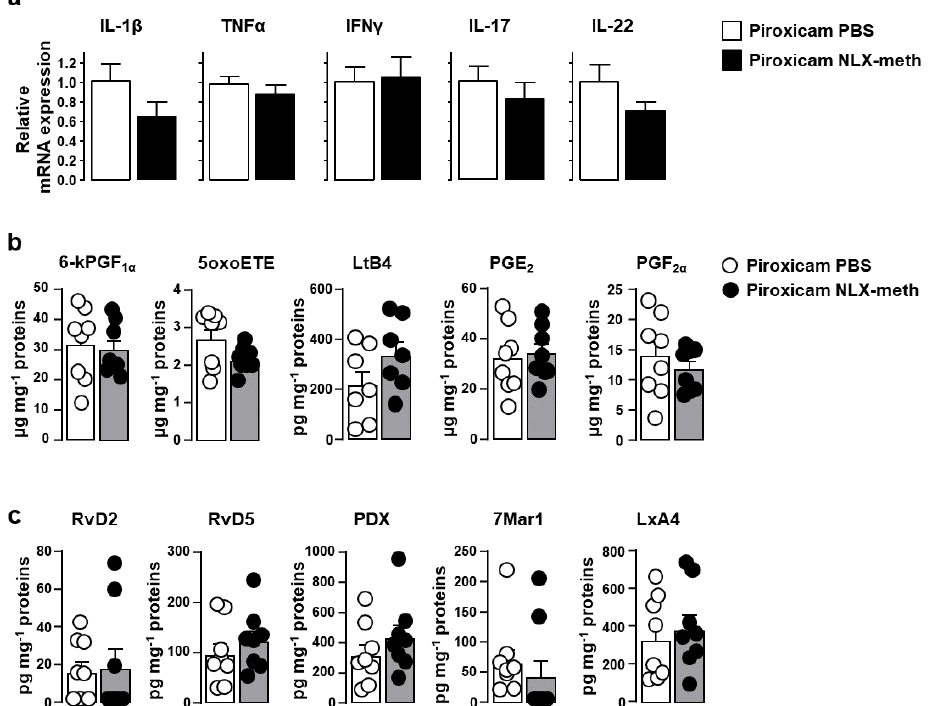
Figure 5. Effects of peripheral opioid receptor blockade on inflammation-related parameters in piroxicam-treated IL-10 -/- . IL10 -/- mice were injected with PBS (white symbols) or naloxone- methiodide (NLX-meth) (black symbols) two days apart for the ten days of piroxicam treatment. mRNA encoding for pro-inflammatory cytokines IL-1 β , TNF α , IFN γ , IL-17, IL-22 was quantified by real-time PCR in colonic biopsies ( a ) ( n = 13–17/group) as described above. Data are expressed as mean ± SEM. Pro-inflammatory ( b ) and pro-resolving ( c ) bioactive lipids were quantified by LC-MS/MS as expressed in pg or µ g per milligrams of colonic tissue proteins ( n = 8/group). Each symbol represents 1 mouse. Statistical analysis was performed using the Mann-Whitney U test.